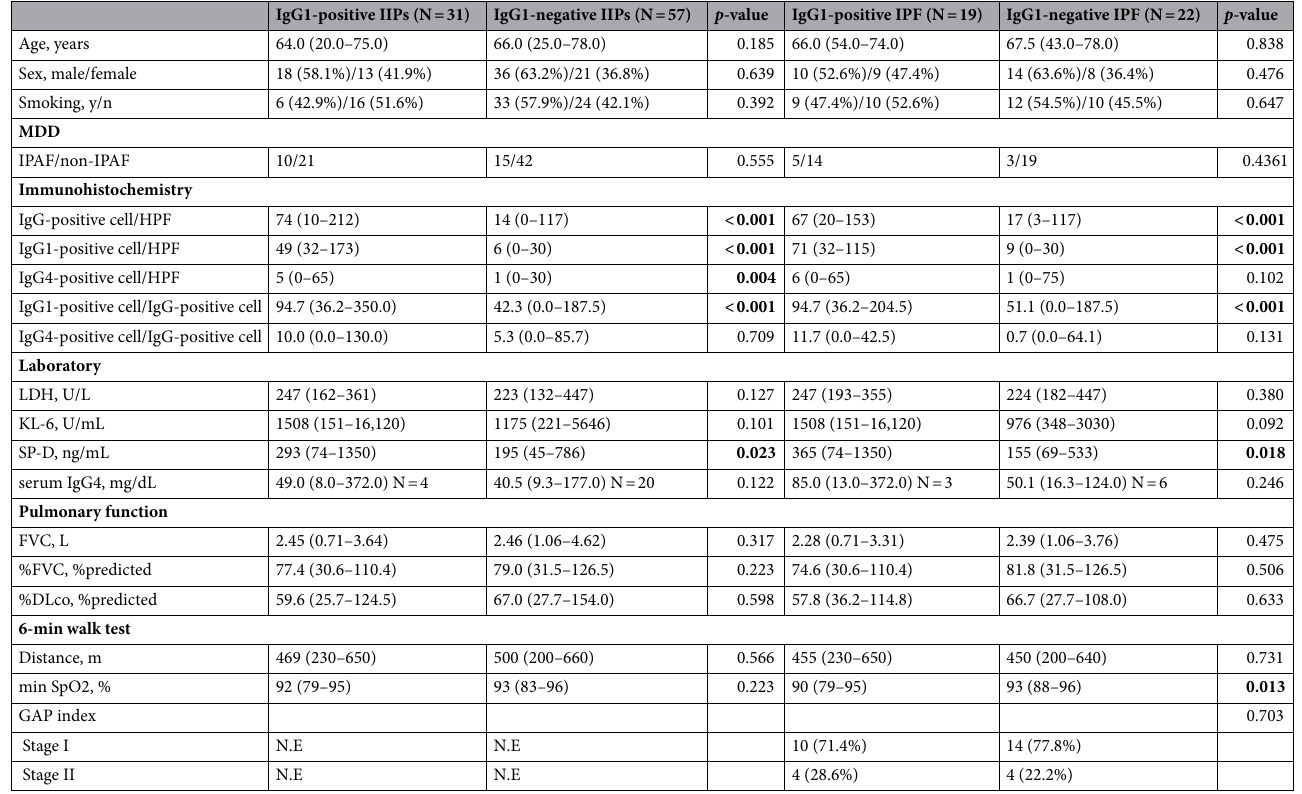
Table 4. Characteristics of patients with IIPs and IPF with or without IgG1-positive cell infiltration. Data are presented as the median (range) or N (%). Bold font: p -value < 0.05. DLco diffusing capacity of the lung for carbon monoxide, FVC forced vital capacity, GAP gender, age, physiological variable, HPF high-power field, Ig immunoglobulin, IIP idiopathic interstitial pneumonia, IPAF interstitial pneumonia with autoimmune features, IPF idiopathic pulmonary fibrosis, KL-6 Krebs von Lungen-6, LDH lactate dehydrogenase, MDD multidisciplinary discussion, N.E. not evaluable; SP surfactant protein, y/n